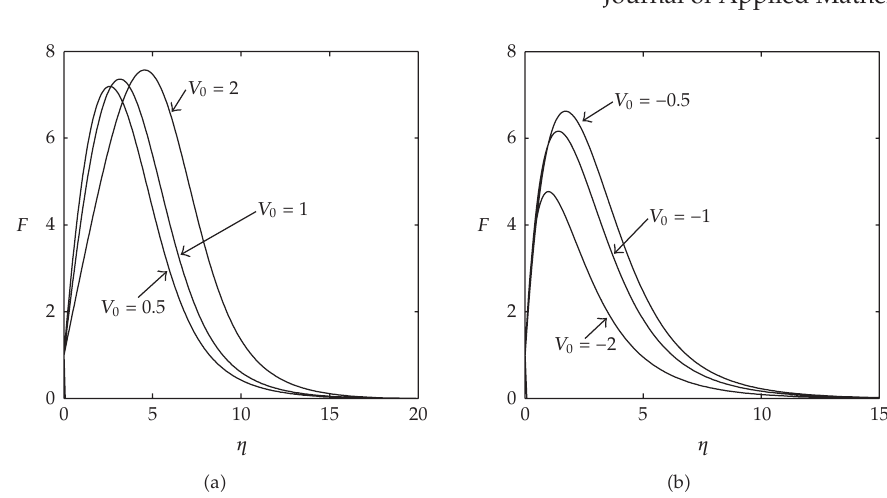
Figure 1: The variation of the velocity distribution with increasing (cid:8) a (cid:9) injection parameter and (cid:8) b (cid:9) suction parameter with ξ (cid:7) 5 , Gr (cid:7) G c (cid:7) 1 , Pr (cid:7) 0 . 72 , Sc (cid:7) 1 , R (cid:7) 1